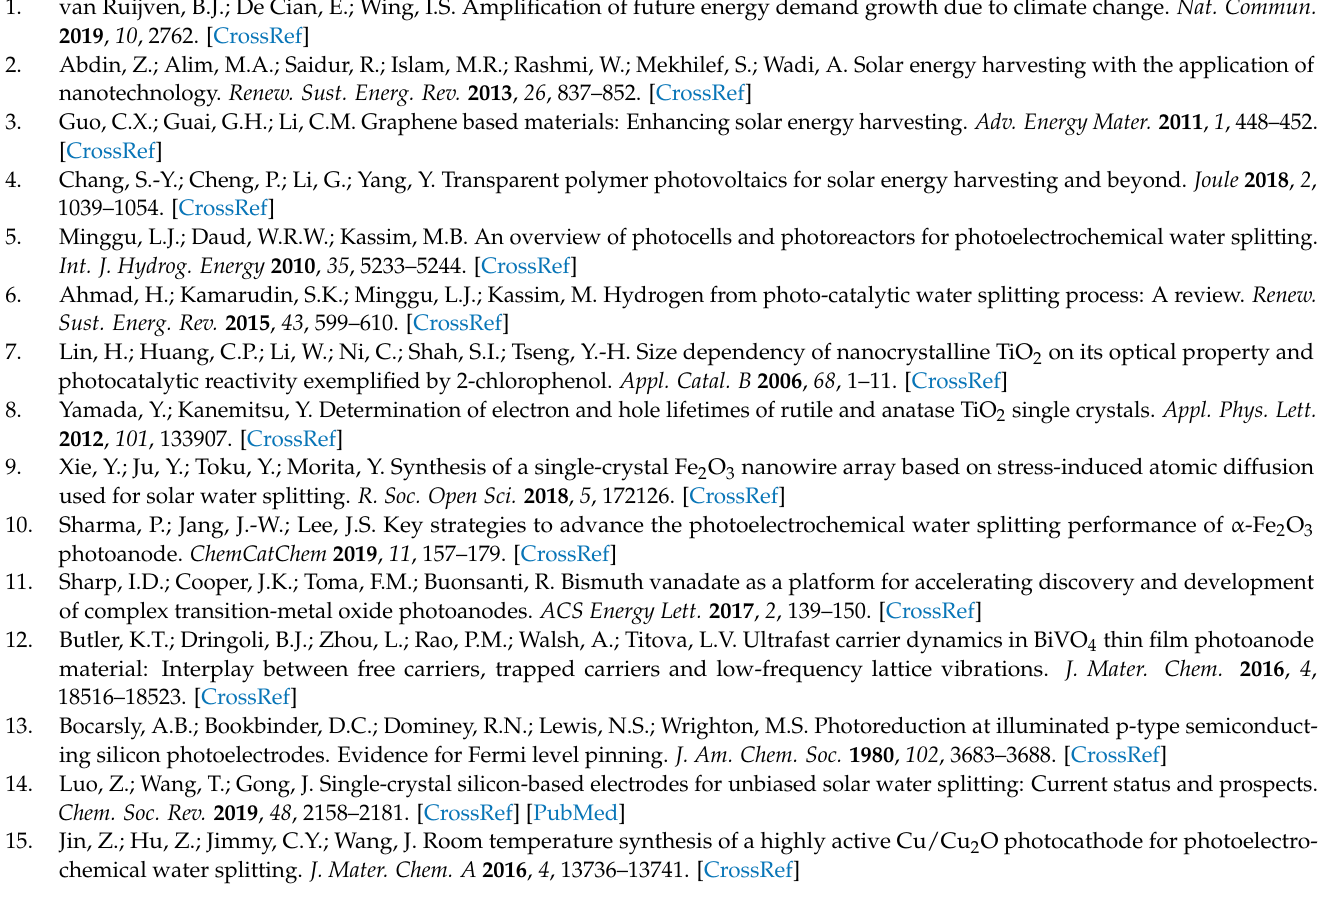
films, Table S4: Band gaps of Cu 2 O, CuO/Cu 2 O, and CuO thin films, Table S5: EIS